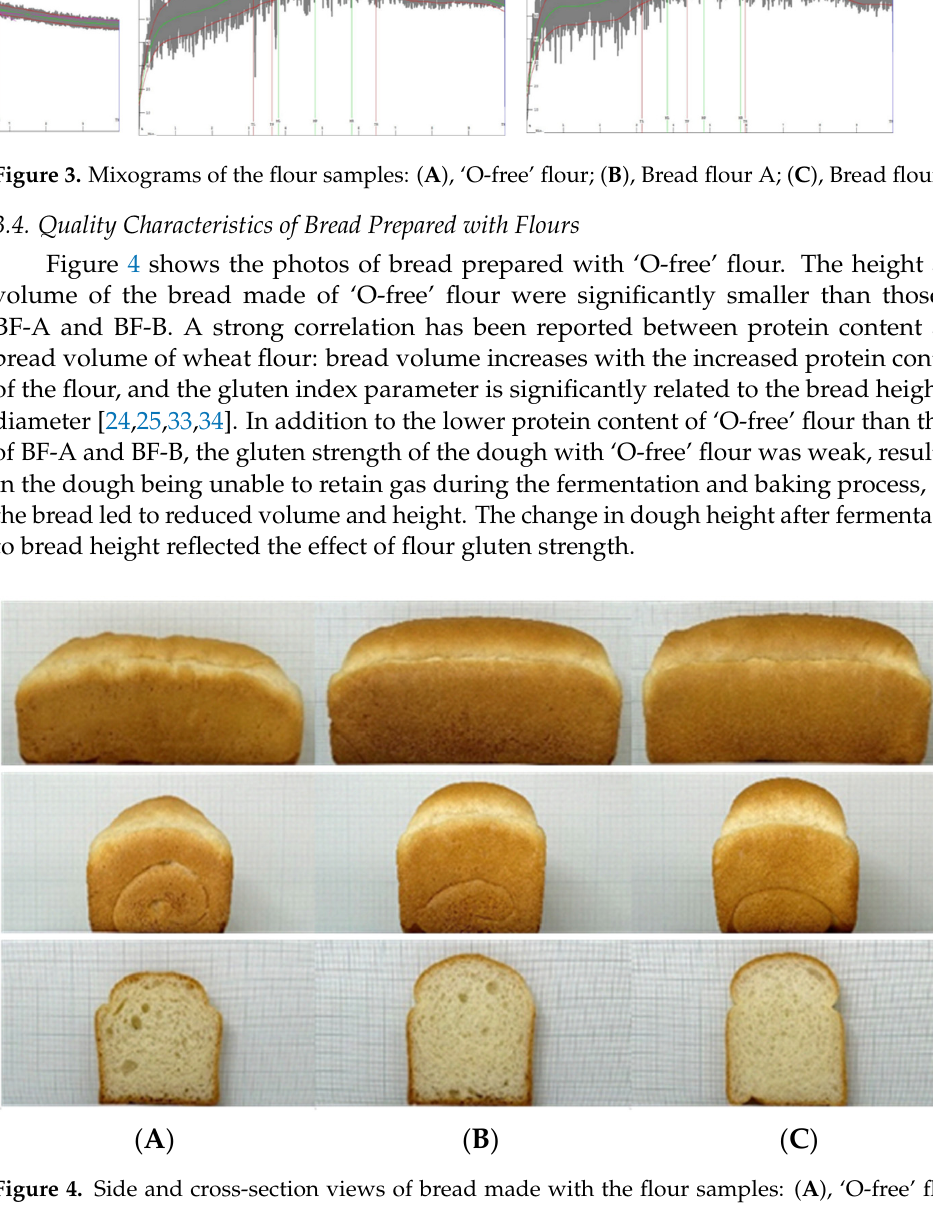
c Figure 2. SDS sedimentation volume of the flour samples. The different letters above the symbols in line plots are significantly different at p < 0.05, according to Tukey’s HSD test. 3.3. Dough Mixing Property of Flours Figure 3 shows the dough mixing patterns (mixograms) of the flour samples, provid ‐ ing information on mixing time requirement and tolerance. The mixing pattern of ‘O ‐ free’ flour differed significantly from those of BF ‐ A and BF ‐ B. Although the time to reach the peak of ‘O ‐ free’ flour was similar to those of BF ‐ A and BF ‐ B, the midline peak height of ‘O ‐ free’ flour was lower, and the bandwidths of the peak and after reaching the peak were much narrower than those of BF ‐ A and BF ‐ B, indicating poor mixing tolerance. Moonen et al. [31] reported that the peak height of the mixogram is related to the flour’s protein content. Therefore, it could be considered that the protein content and dough viscoelas ‐